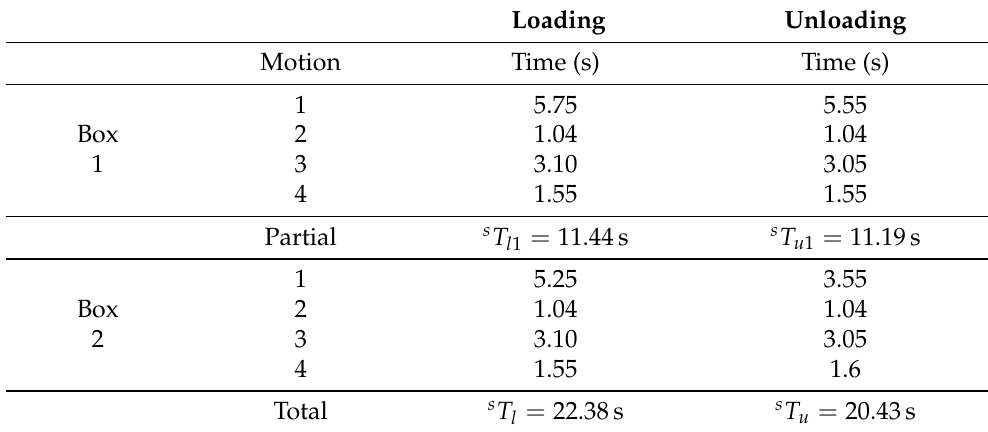
Table 1. Simulated elapsed time for loading/unloading two aligned